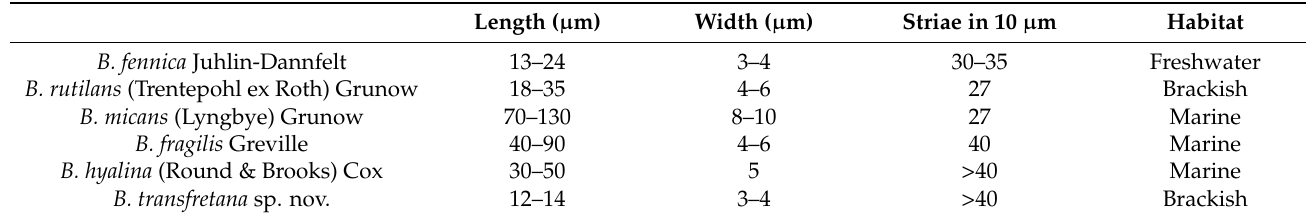
Table 1. Diagnostic features of B. transfretana and similar